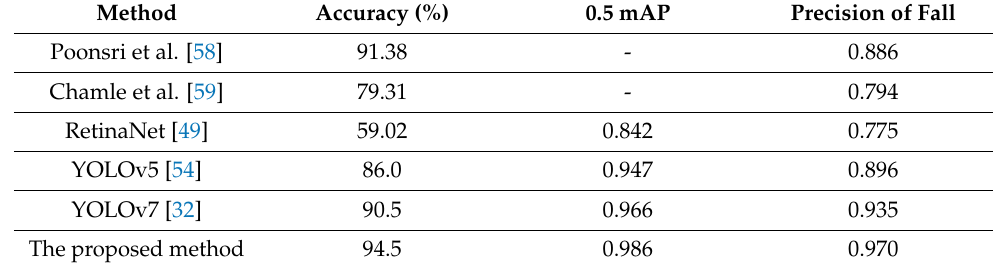
Table 4. Performance of the different state-of-the-art methods on Le2i dataset.